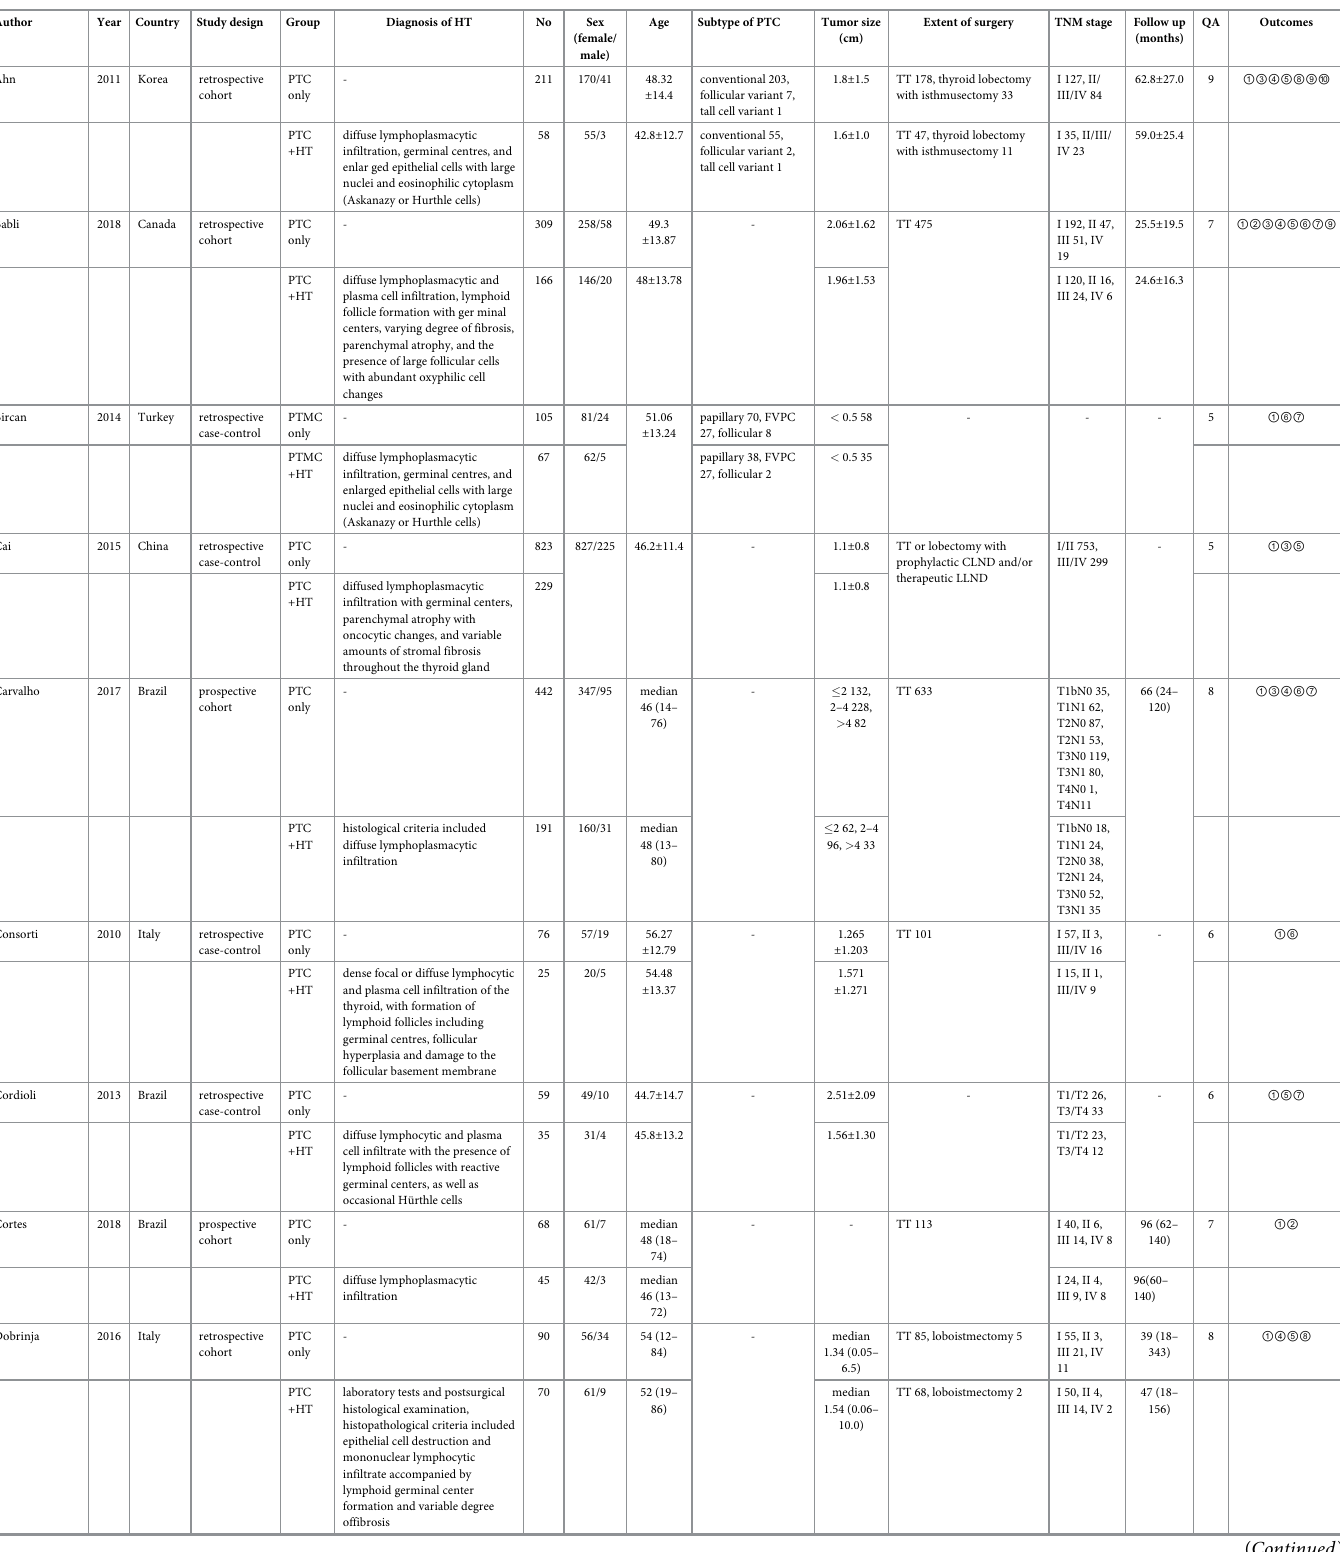
Table 1. Basic characteristics of included